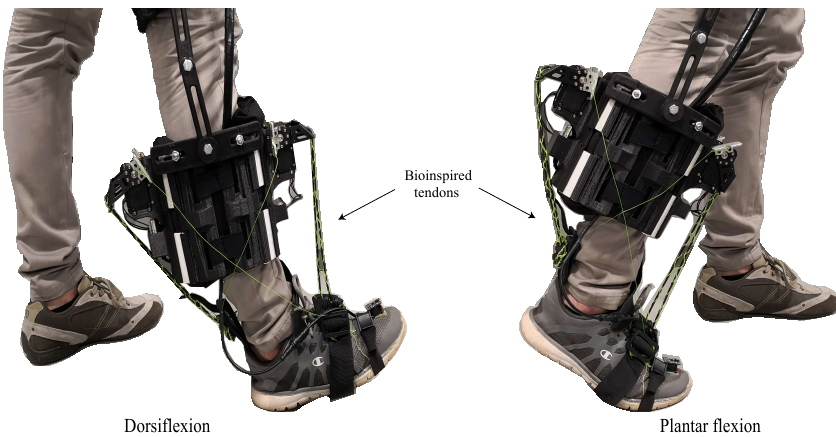
Figure 2. T-Flex: wearable ankle—foot robotic orthoses. Both movements, dorsiflexion and plantar flexion, are produced by means of the elastic tendons attached in series to the